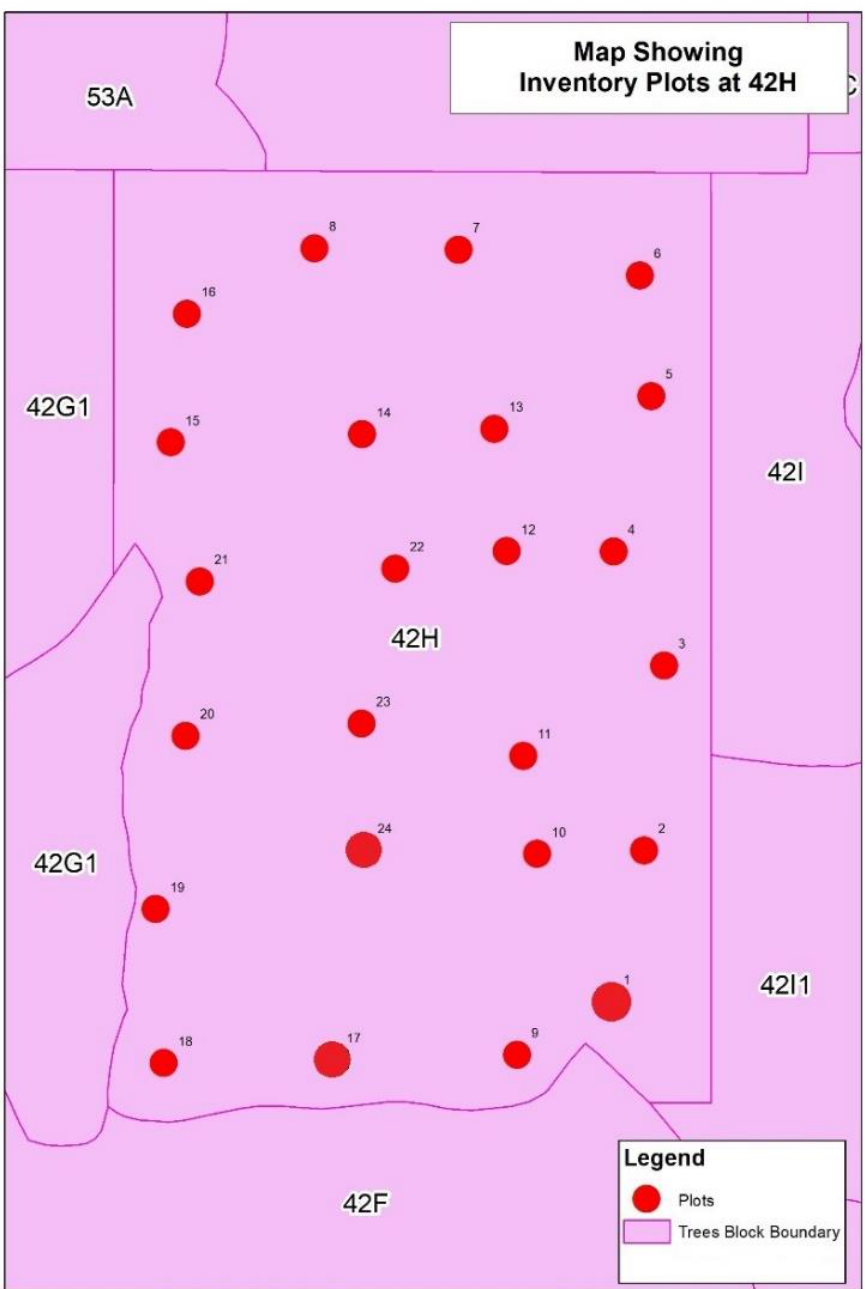
Figure 5. Schematic of the 24 inventory plots within Block 42H.